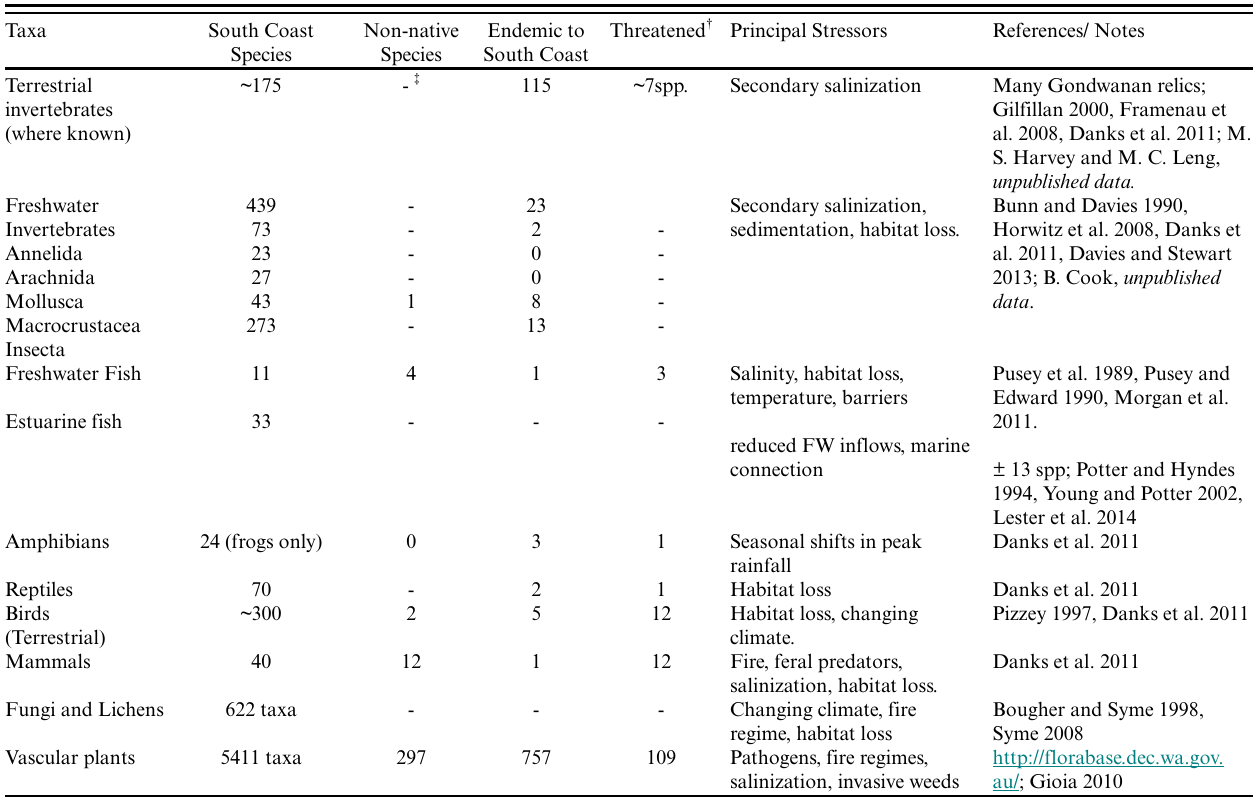
Table 1 . Overview of known major taxa identified in the South Coast Region of Western Australia. For this list no attempt was made to distinguish current distribution from historical